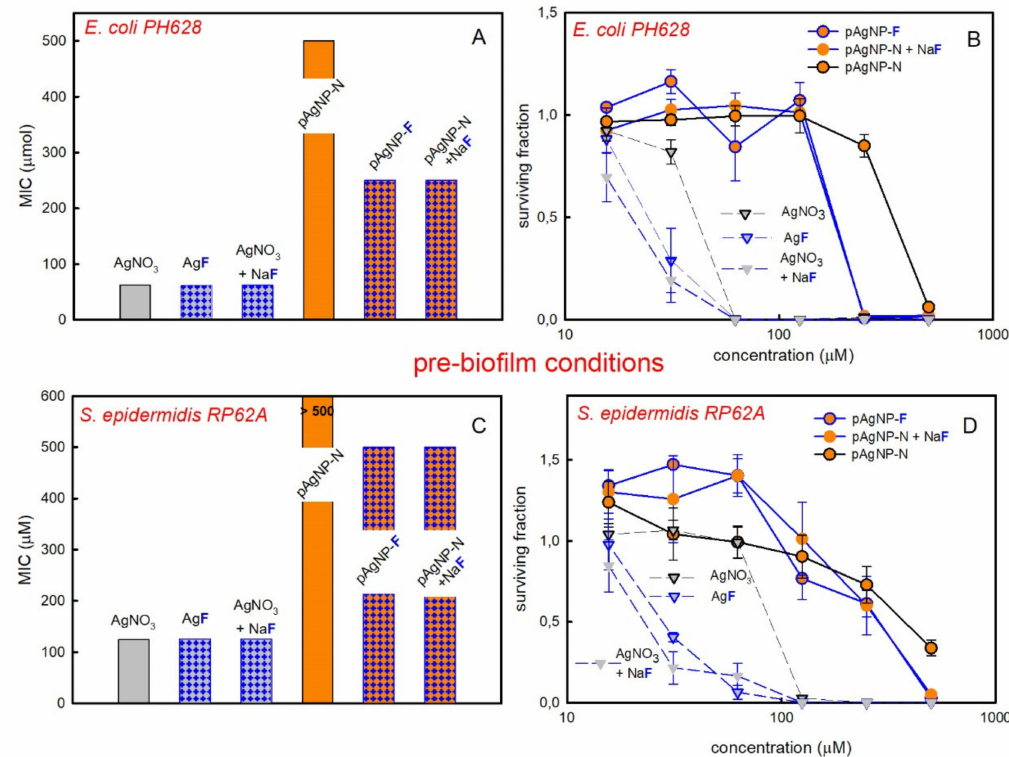
Figure 3. Data for pre-biofilm conditions. ( A ): MIC values for E. coli PH628 , grey bars refer to the e ff ect of ionic silver and orange bars to the e ff ect of pAgNP, blue checkers visually evidence data for treatments containing F − . ( B ): surviving fraction values for E. coli PH628 vs silver concentration; orange circles refer p-AgNP, blue outlines and / or blue solid lines (drawn to guide the eye) define treatments containing F − (see legend in figure for exact match); ( C ): same as ( A ), for S. epidermidis RP62A ; ( D ): same as ( B ), for S. epidermidis RP62A